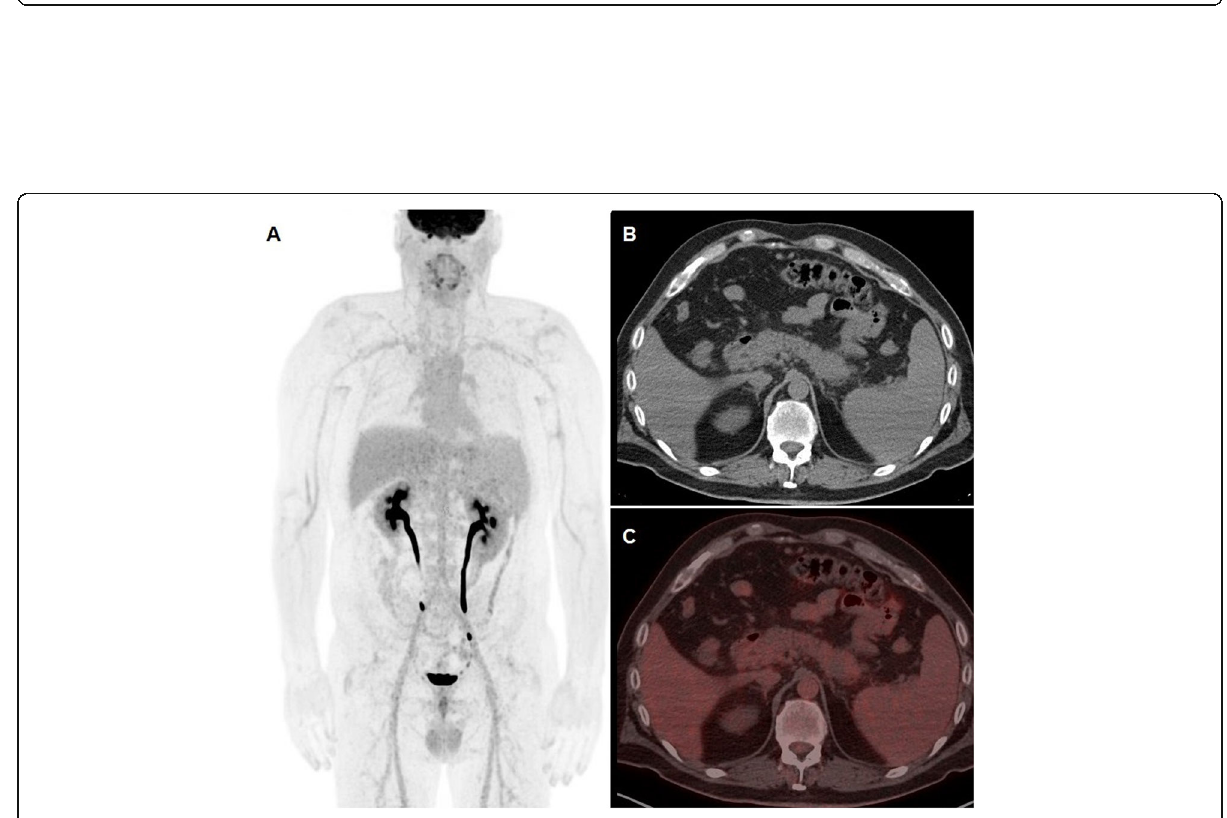
Fig. 2 Whole body PET/CT ( A ), CT ( B ) and fused PET/CT ( C ) slices showed complete regression of the hypermetabolic lesions previously described in the left arm and